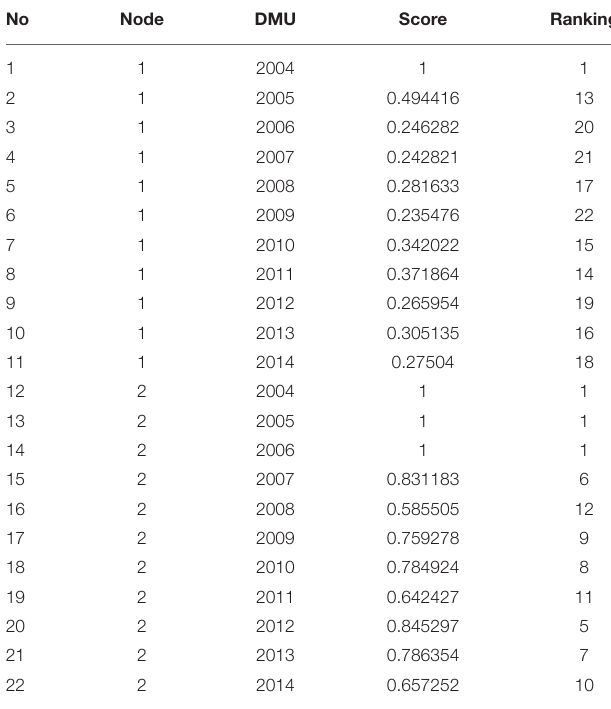
TABLE 3 | Results of the two-stage network DEA